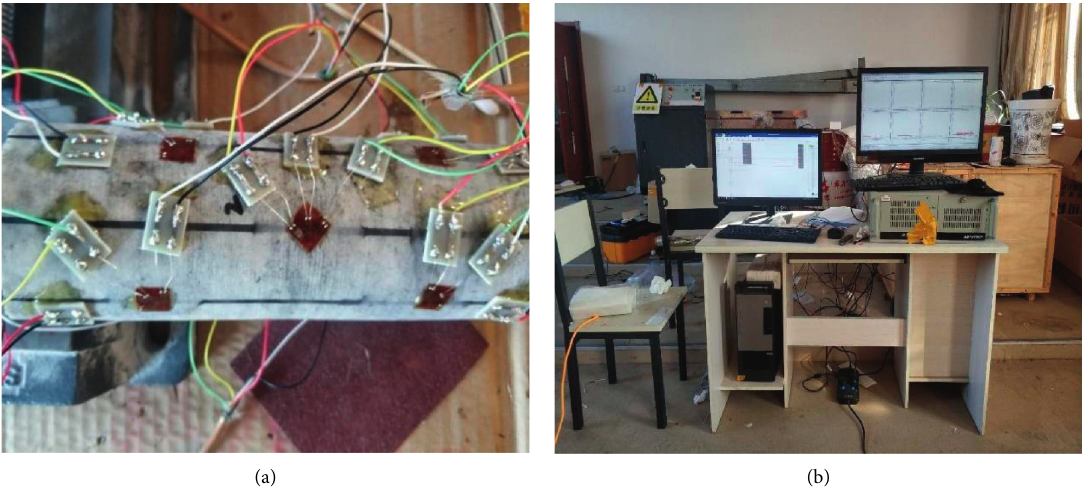
Figure 5: (a) Layout of core strain gauges in an actual test; (b) signal acquisition of ASR in situ stress measurement experiment.